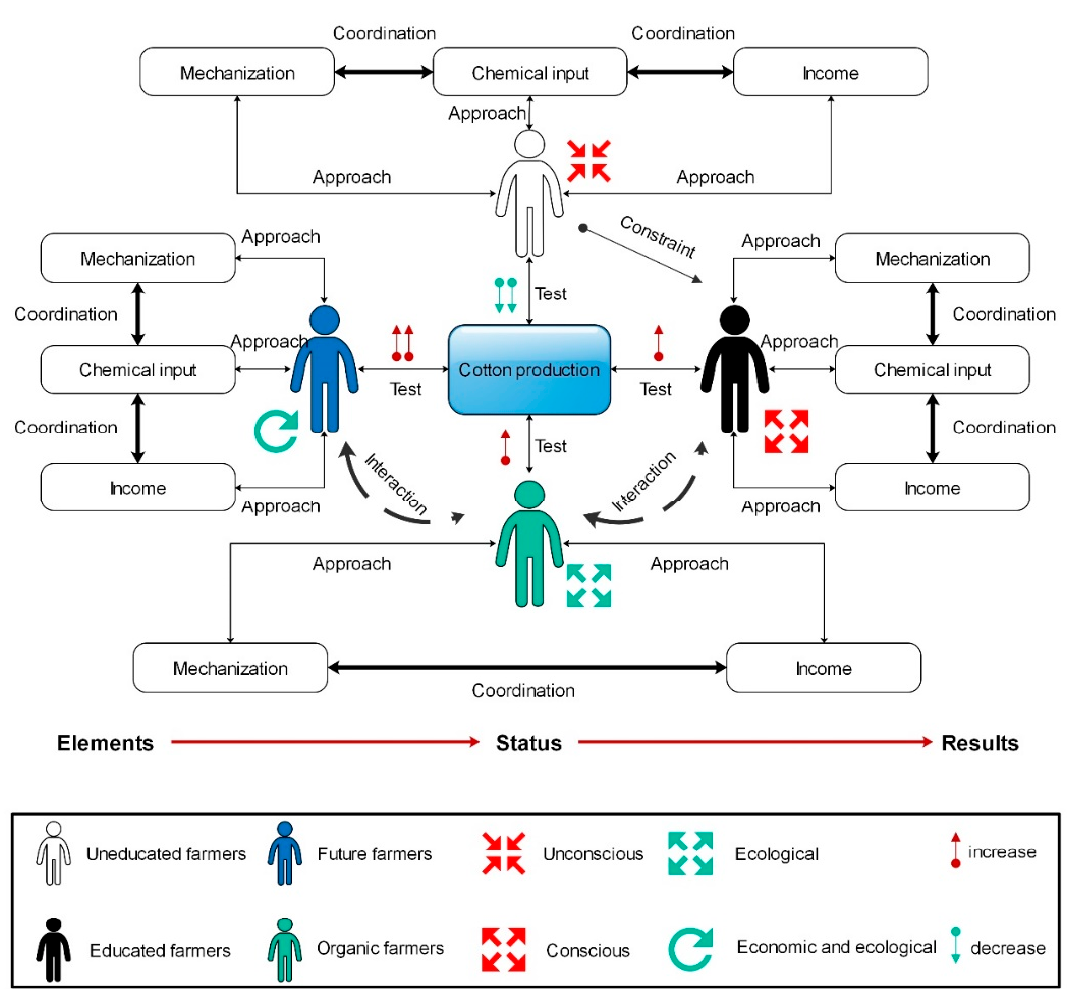
Figure 2. Research framework based on the study area.